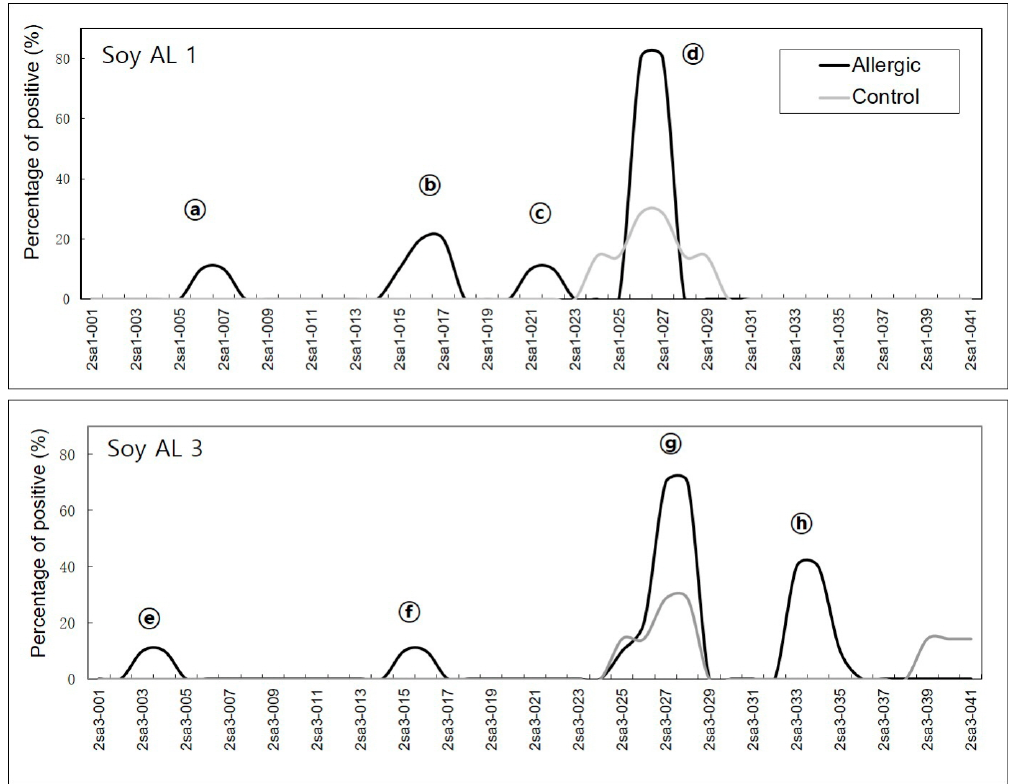
Figure 1. Positive binding in Soy Al 1 and Soy Al 3 are shown as alphabet characters. The X -axis of the graph represents each peptide. The Y -axis of the graph represents the percentage of positive binding.